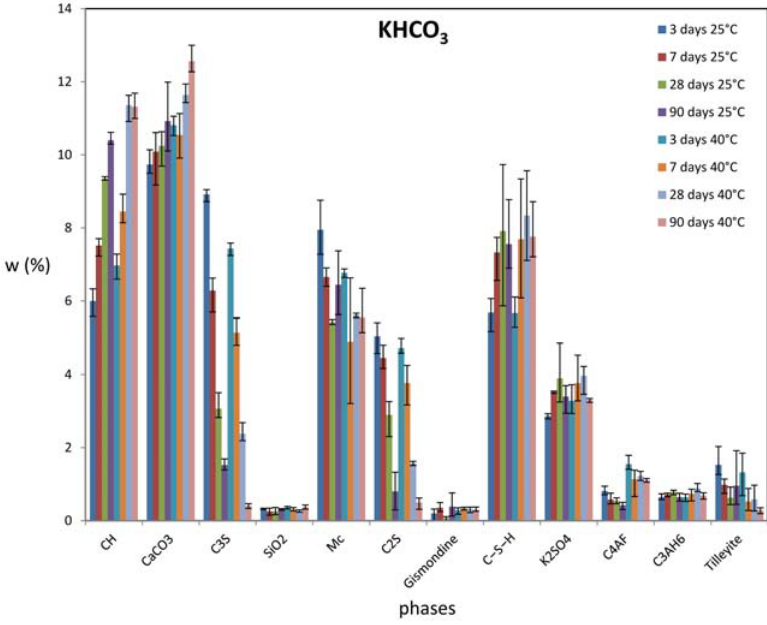
Figure 8. The quantitative analysis of hydration products in cements with added KHCO 25 and 40